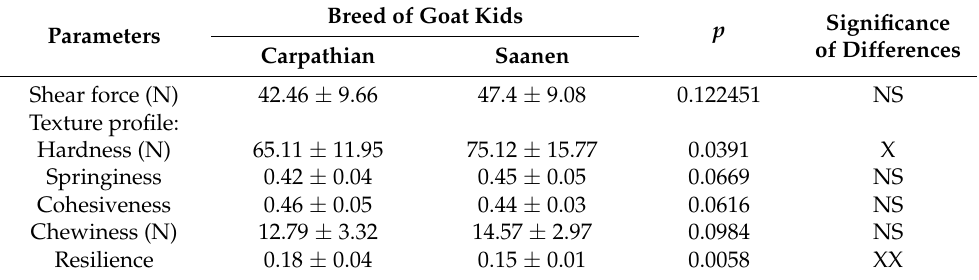
Table 2. Texture parameters and shear force value ( ± SE) of the goat kid meat.